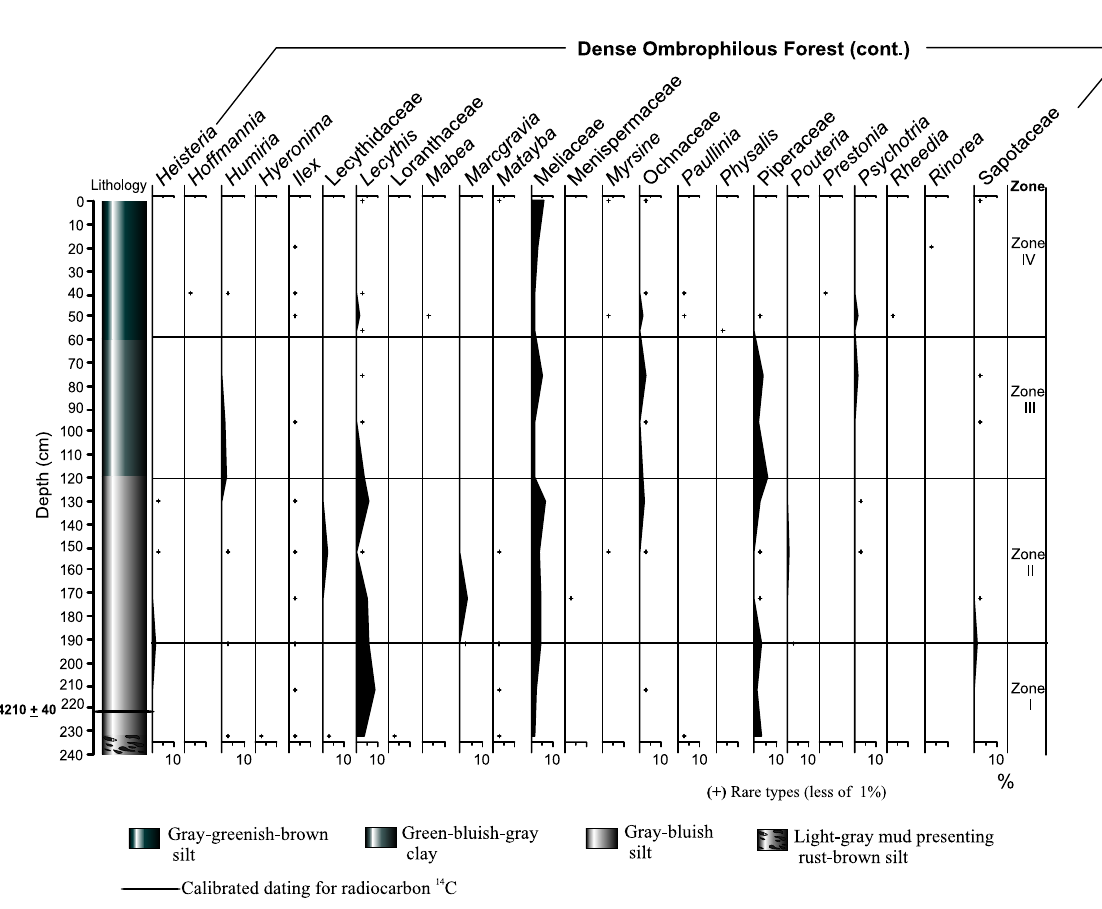
Fig. 4 – Percentage palynodiagram of the pollen types grouped into the Dense Ombrophilous Forest (cont.) recognized in the core of Guanabara